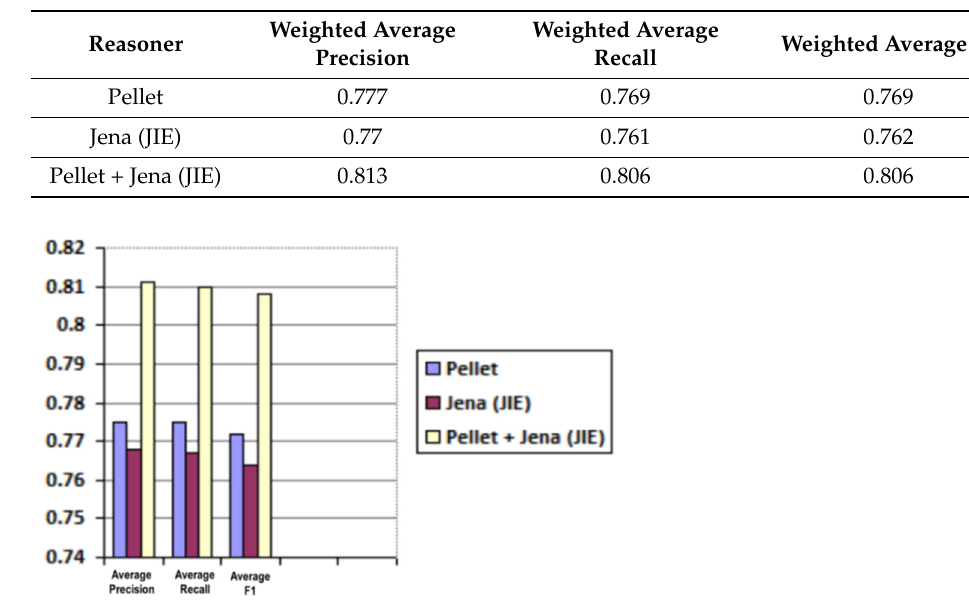
Table 3. Predicted roles evaluation (average values for precision, recall and F1).